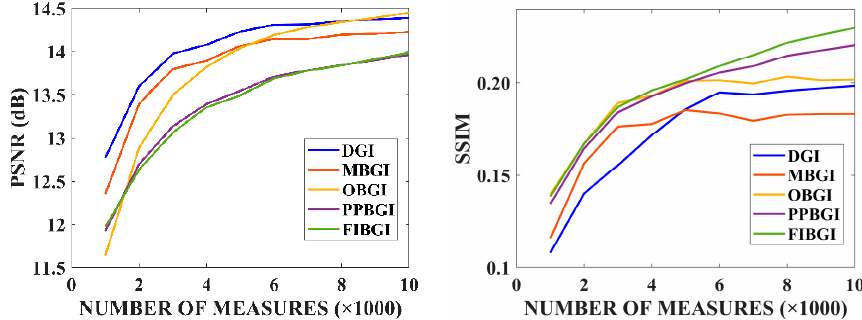
Figure 7. The quantitative comparisons of grayscale target with different methods.